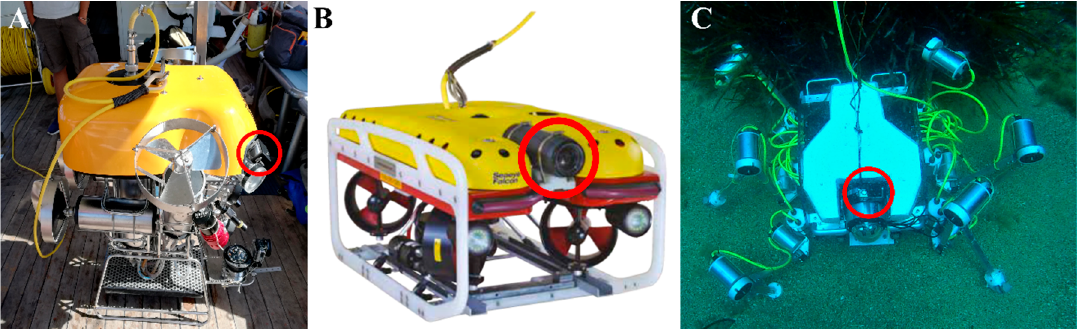
Figure 1. Underwater robots used in this work: ( A ) Prometeo, ( B ) Falcon, and ( C ) SILVER2. The cameras used for recording are marked with a red circle.